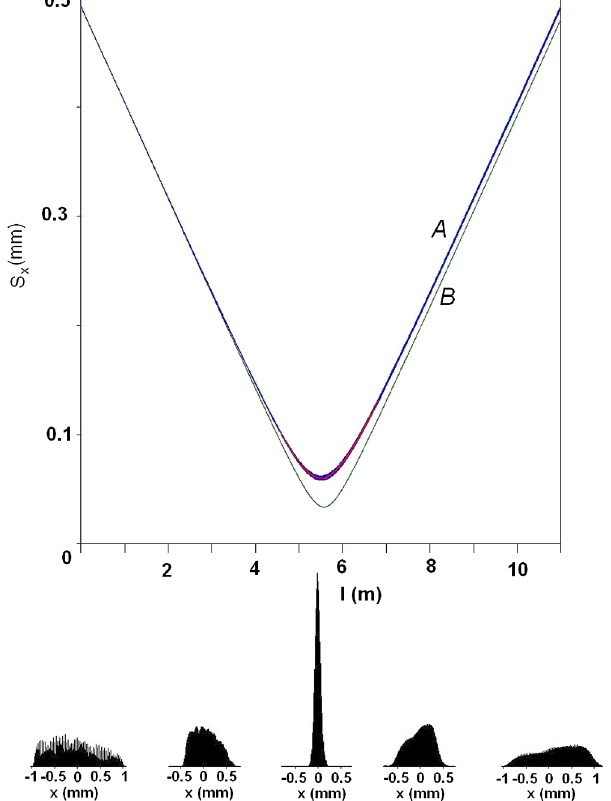
FIG. 8. Top panel: results for the envelope reconstruction of the 400 GeV =c proton beam as a function of distance l from the crystal deflector. The two lines labeled A are calculated using Eqs. (1) and (8) (blue and red lines, respectively), and they practically coincide. The width of the blue line corresponds to measurement uncertainties [20]. Near the focal point, the un- certainty is the largest and is equal to ≈ 0 . 0025 mm. Line B is a prediction for the case when the beam propagates in vacuum downstream of the crystal. Bottom panel: the beam profiles (from left to right) for l ¼ 0 ; L f = 2 ; L f ; 3 L f = 2 ; 2 L f ,